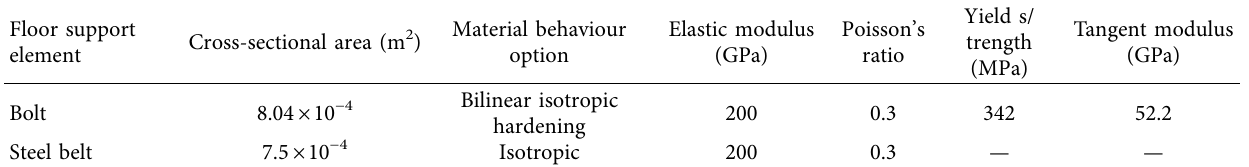
Figure 12: Te relationship between joint spacing in the immediate foor and foor heave and vertical plastic strain distribution around the roadway for steps 5 and Table 4: Properties of foor support elements used in the model.